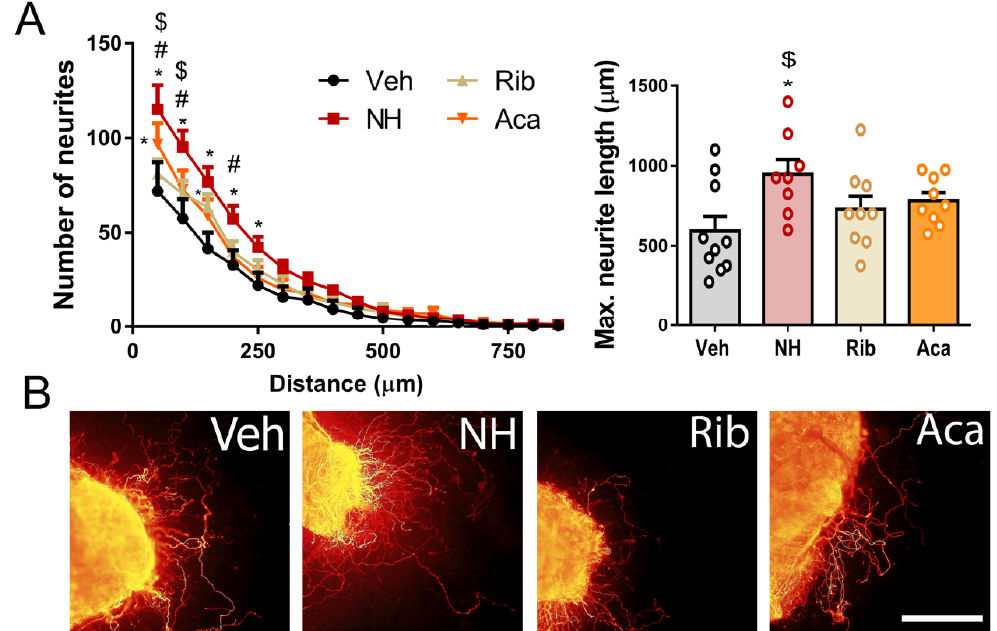
Figure 1. NeuroHeal increases neuritogenesis in vitro. ( A ) Graphs showing the number of neurites per intersection (left) and the maximum neurite length (right) sprouted out from collagen-embedded dorsal root ganglia (DRG) explants ( n = 8–10 biological replicates, ANOVA, post hoc Bonferroni, * p < 0.05 vs. Veh, # vs. Aca and $ vs. Rib, combined with t -test). ( B ) Representative microphotographs of collagen embedded DRGs treated with Vehicle (Veh), NeuroHeal (NH), Acamprosate (Aca), and Ribavirin (Rib). Scale bar = 250 μM.